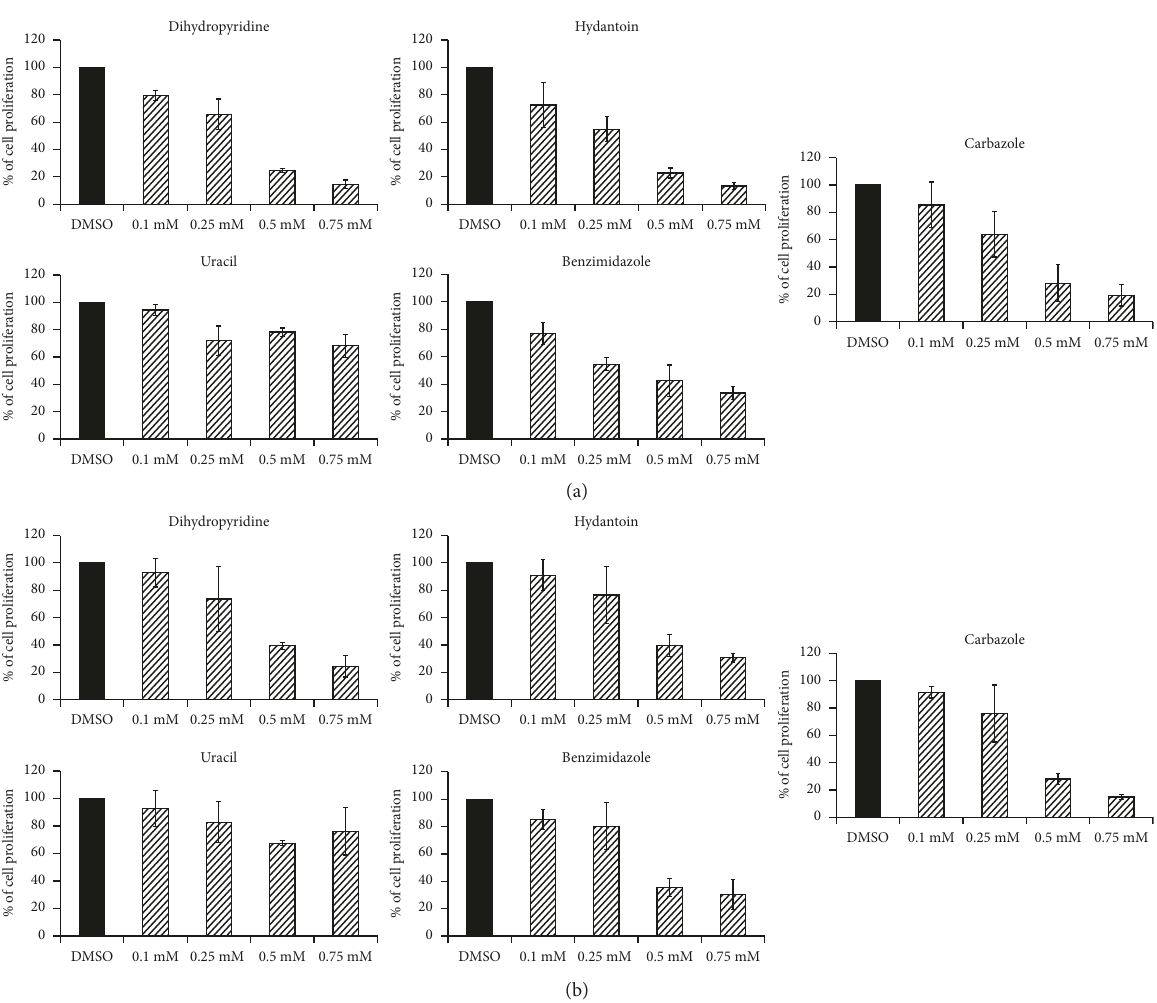
Figure 2: SiHa and CasKi cells were treated with the five hybrid fluoroquinolones 3a–e at different doses. (a) SiHa cells treatment shows a gradual inhibitory effect with compounds 3a , 3b , 3d , and 3e . (b) CasKi cells treatment shows a gradual effect with 3a while the abrupt effect was noticed with 3b , 3d , and 3e